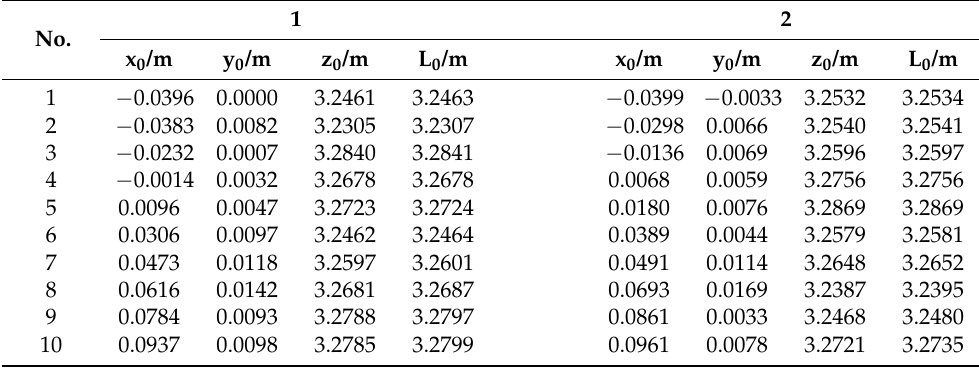
Table 3. Coordinates and distance of the target